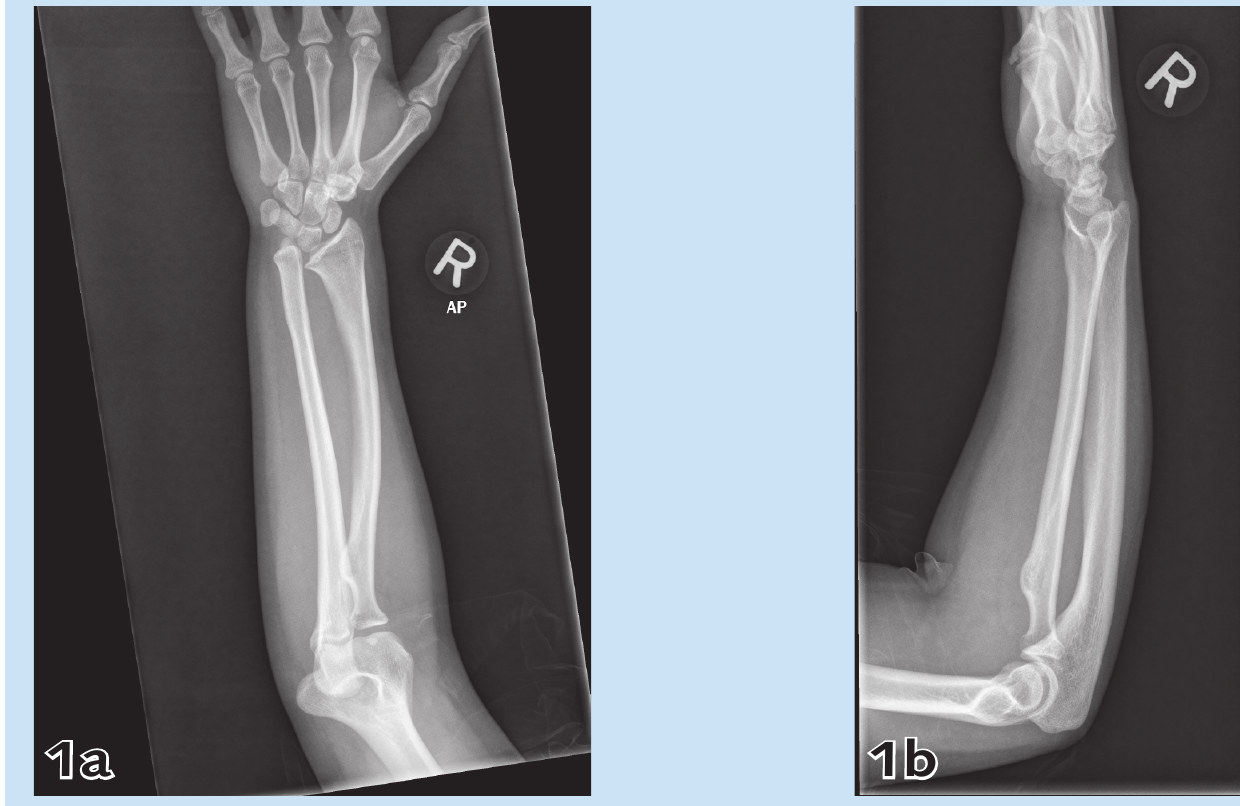
Figs. 1a and 1b. Antero-posterior and lateral radiographs of the right forearm demonstrating the typical features of Madelung deformity: bowing and shortening of the distal radius, widening of the distal radial-ulnar joint, and triangulation of the distal radial epiphysis, producing an ulnar slant to the articular